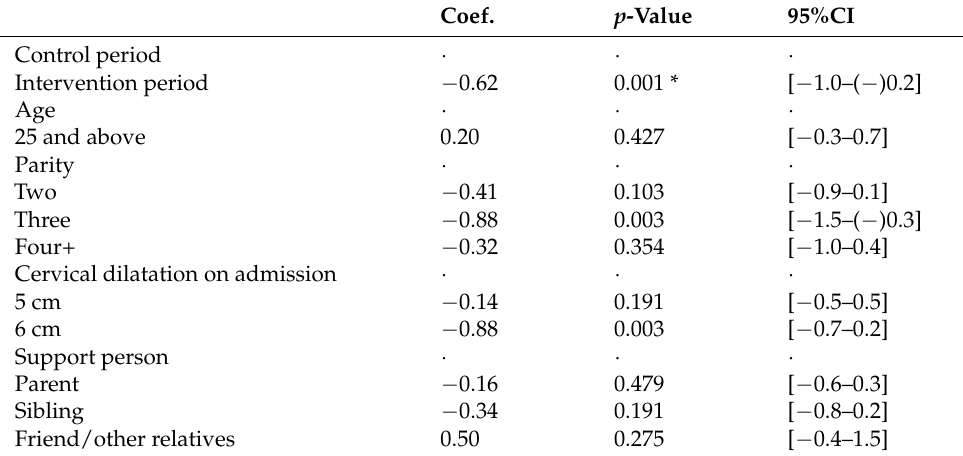
Table 3. Multivariable analysis of the effect of continuous labor support on maternal anxiety.